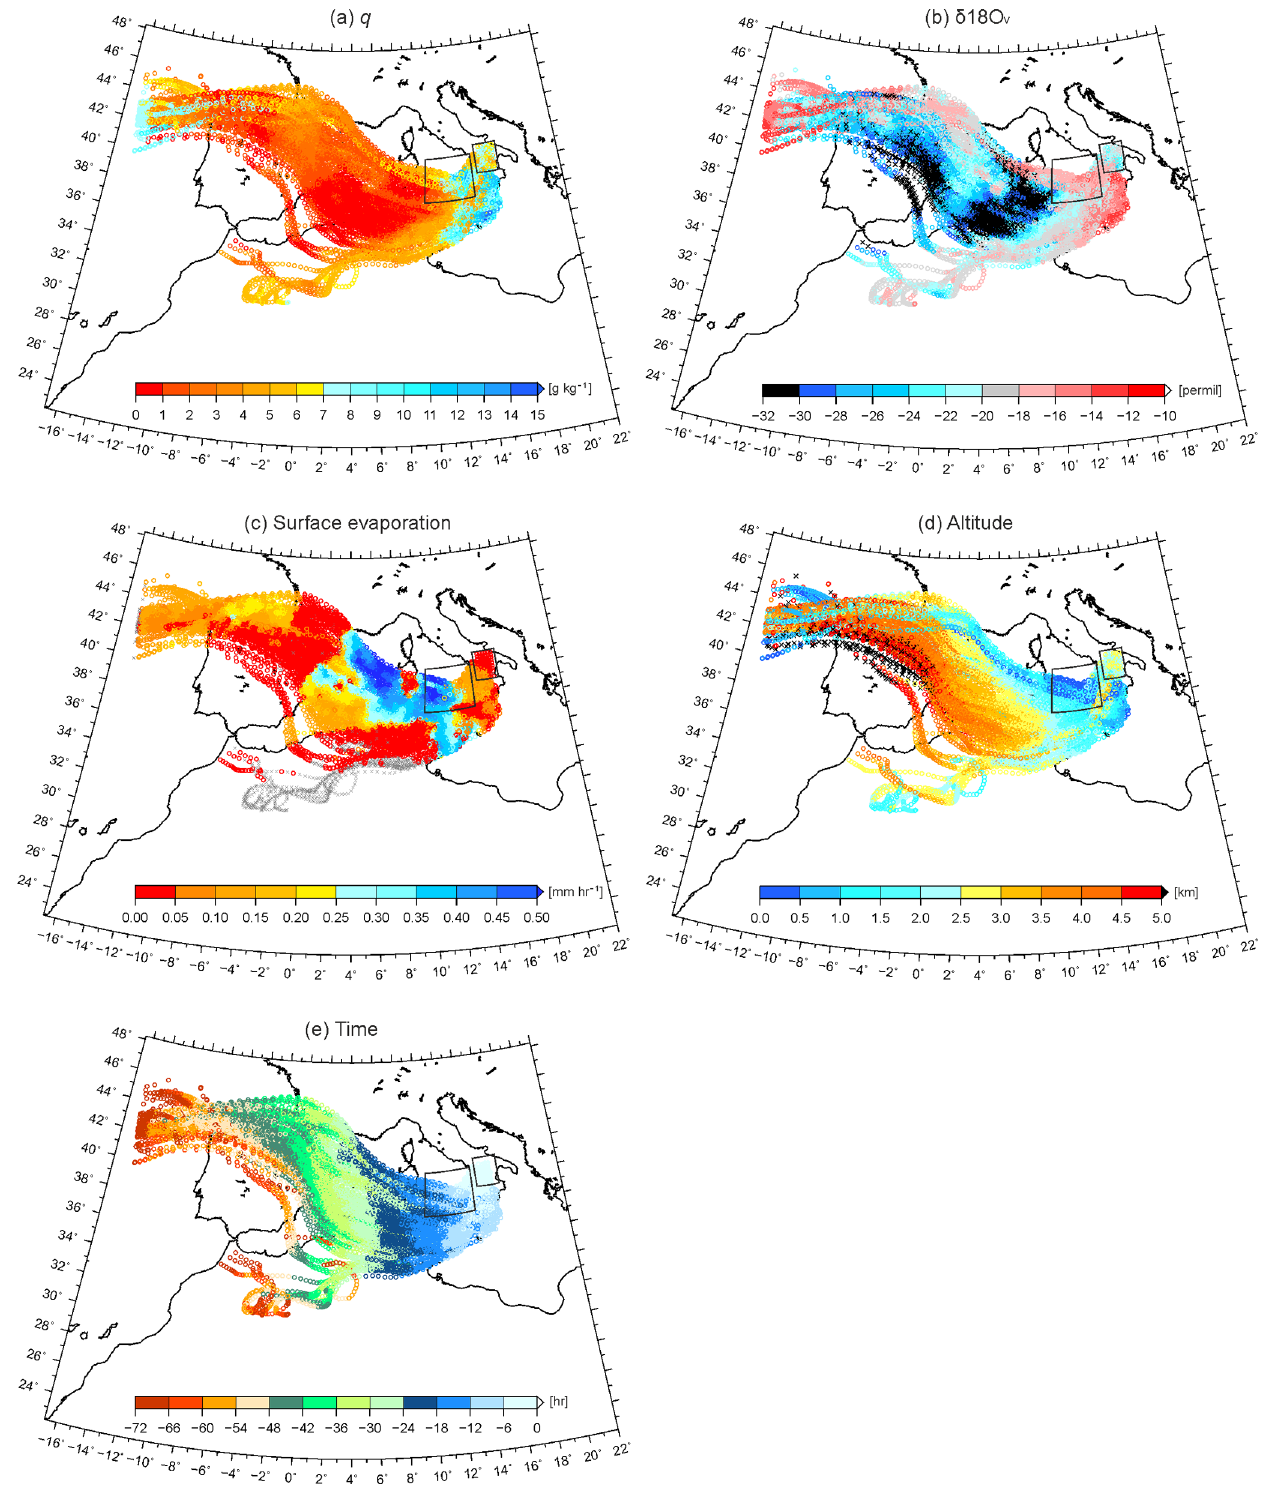
Figure 7. History of air parcel arriving at SI in the 800–700 hPa layer at 20:00UTC on 15 October 2012. (a) Water vapour mixing ratio, q (gkg − 1 ), (b) δ 18 O v (‰), (c) surface evaporation (mmh − 1 ), (d) altitude (km), and (e) time (h).